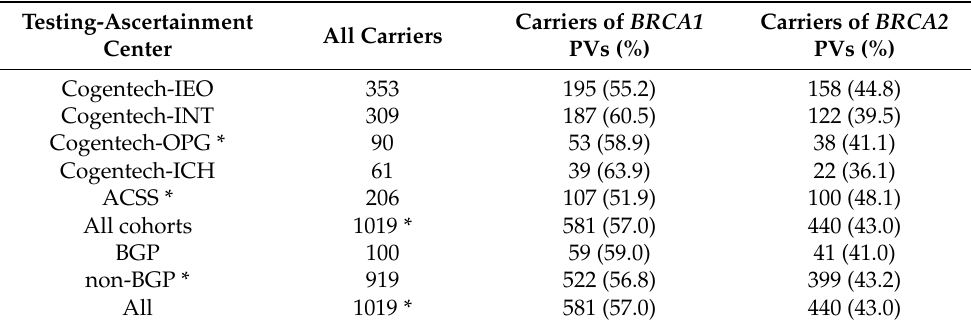
Table 3. Number of carriers of BRCA1 or BRCA2 PVs included in the study by testing ascertainment center and BGP and non-BGP